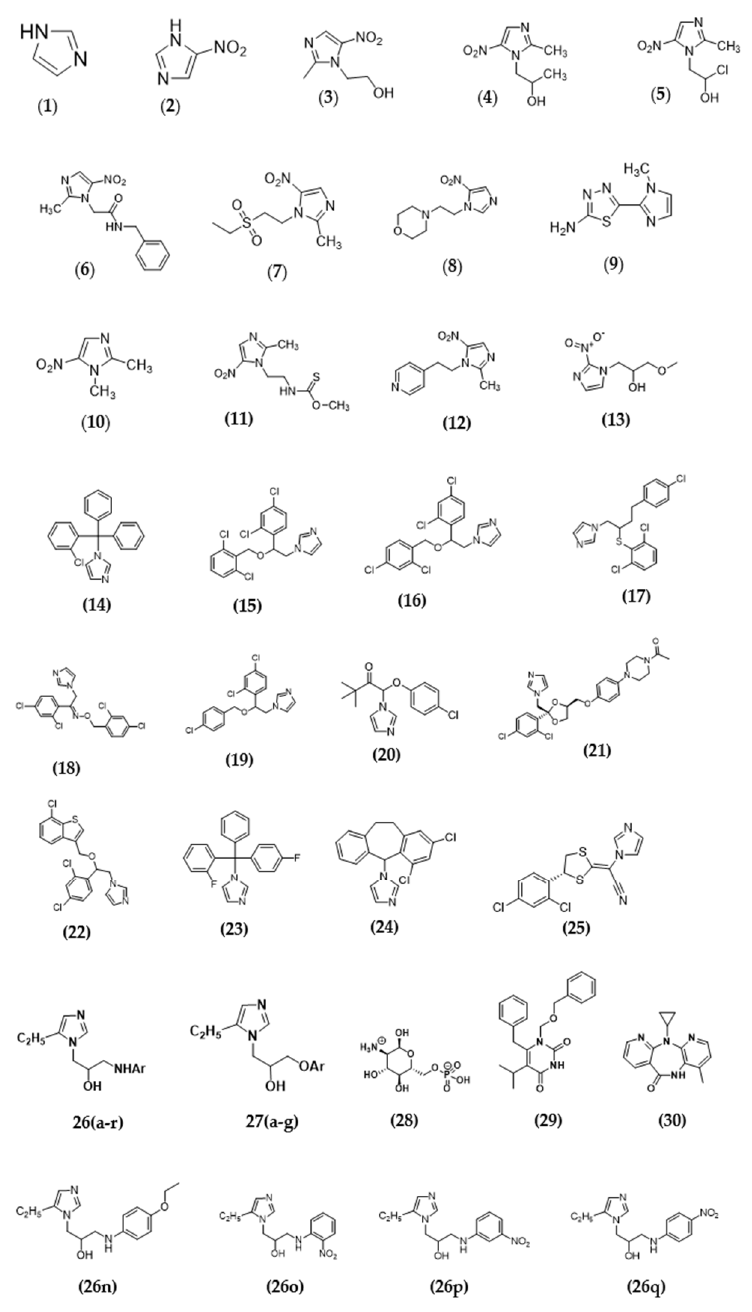
Figure 1. Structures of compounds.